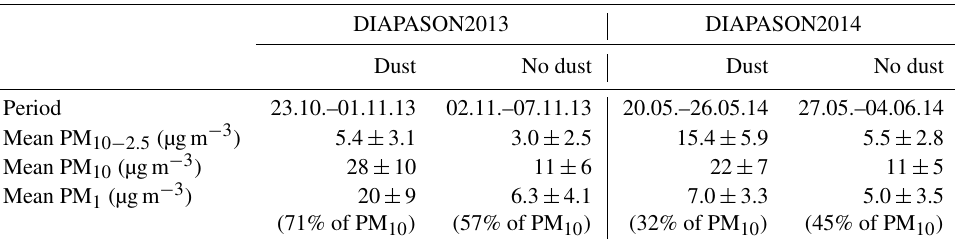
Table 5. Summary of dust and no dust periods identified during DIAPASON2013 and DIAPASON2014, including mean values and standard deviation of PM 10 − 2 . 5 , PM 10 and PM 1 (all from EDM measurements).